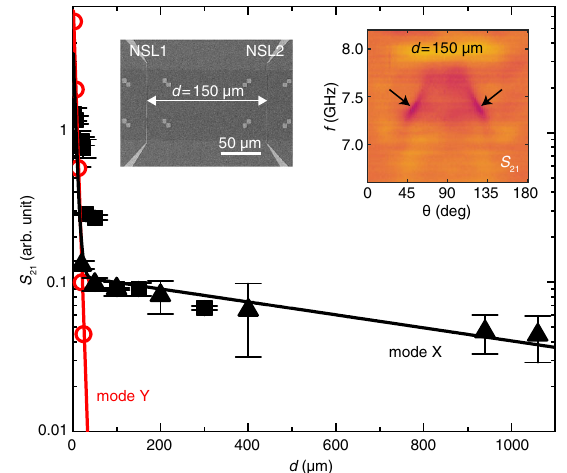
Fig. 5 Long-distance propagation of magnon – phonon hybridized mode at the BFO/LSMO interface. Transmission amplitude S 21 plotted in a logarithmic scale as a function of the distance d between excitation and detection antennas. The left inset shows the SEM image of Sample Z13 with d ¼ 150 µ m as an example. The red open circles are data points extrapolated for mode Y from different samples as shown in Fig. 2a – e. The red solid line is a fi t considering an exponential magnon decay, which yields a magnon decay length λ to be ~5 μ m for mode Y. The black squares (triangles) are data points taken from samples with NSL (CPW) antennas for mode X (Supplementary Figs. 17 and 18). The black solid line is a fi t based on Eq. (2) considering the contributions from a pure magnon mode with a short decay length λ m ≈ 5 μ m in superposition to a magnon – phonon hybridized mode with a long decay length of λ mp ¼ 1mm. The right inset shows angle-dependent transmission spectra S 21 measured on Sample Z13 with an applied fi eld of 100 mT and a propagation distance d ¼ 150 μ m, where the black arrows indicate two branches of mode X attributed to the magnon – phonon hybridized